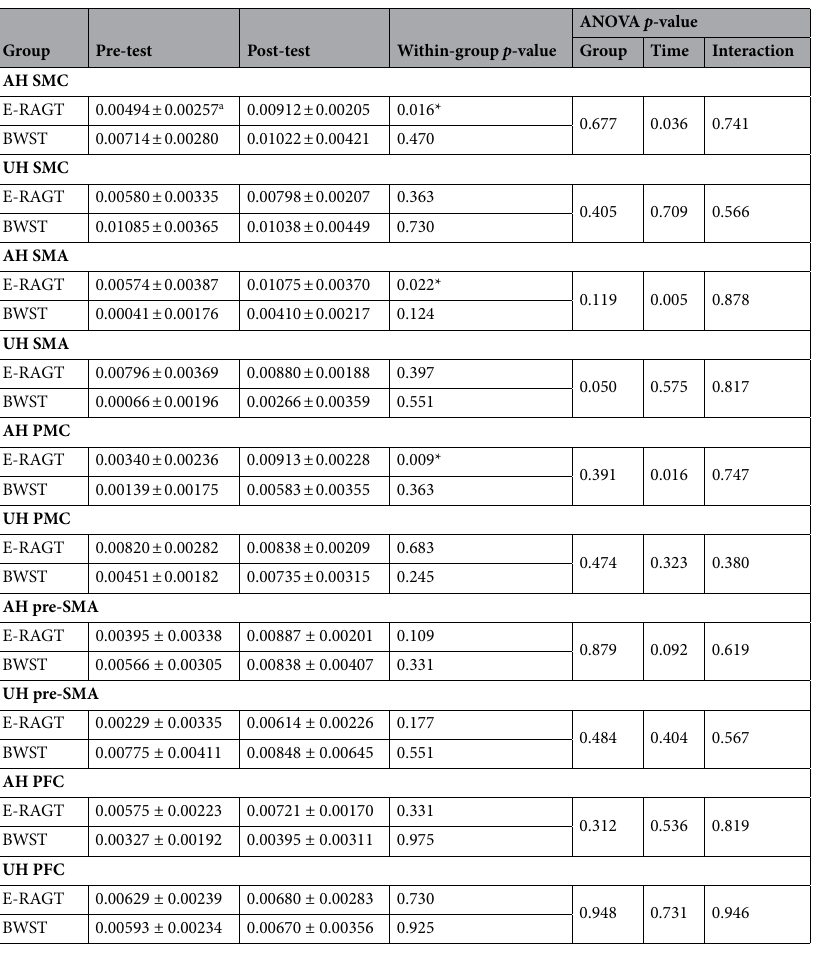
robot-assisted gait training, BWST bodyweight-supported treadmill training, AH affected hemisphere, UH unaffected hemisphere, SMC primary sensorimotor cortex, SMA supplementary motor area, PMC premotor cortex, pre-SMA pre-supplementary motor area, PFC prefrontal cortex. *Significant within-group difference, based on paired t -test, p < 0.05. a Mean ± standard